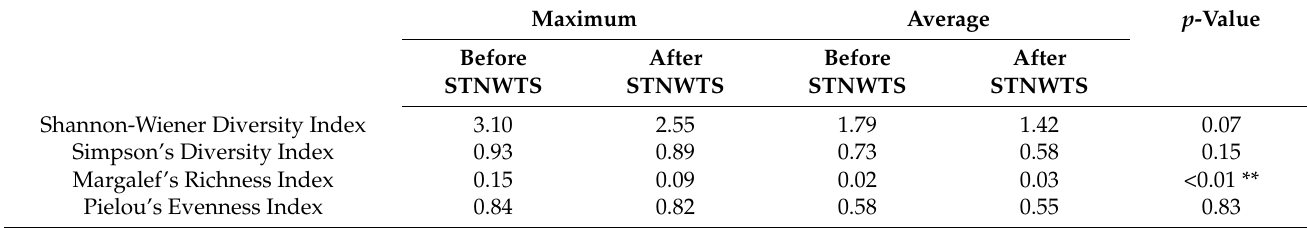
Table 3. Biodiversity indexes of waterbirds during the two study periods.